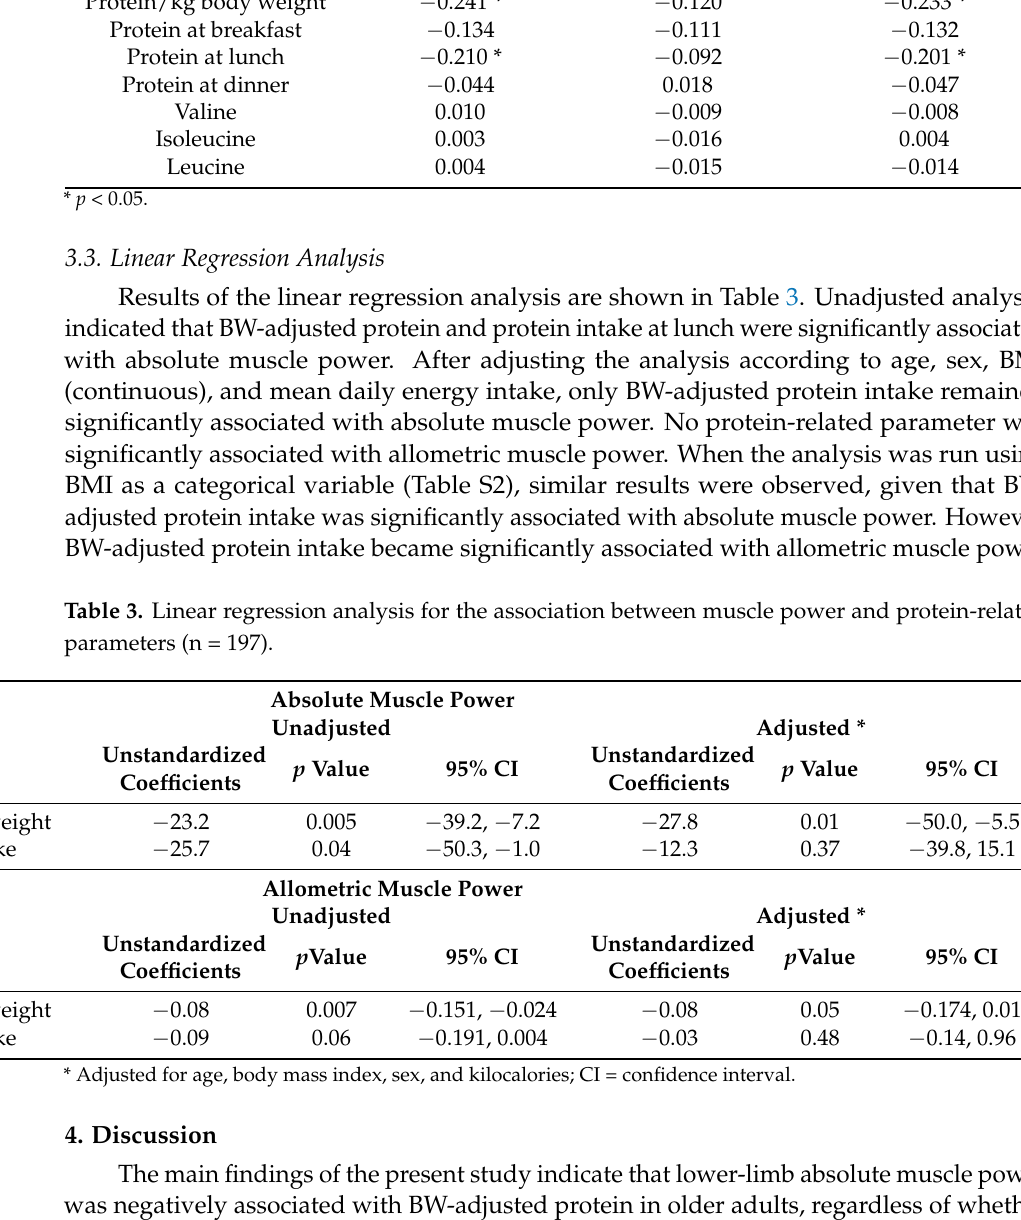
Table 2. Person’s correlation analysis for the association between muscle power and protein-related parameters (n = 197). Variables Kilocalories Protein Protein/kg body weight Protein at breakfast Protein at dinner